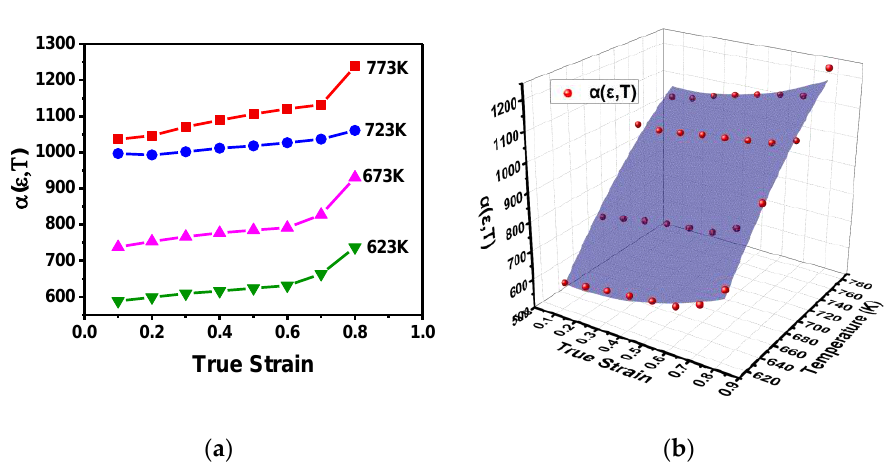
Figure 4. The variation of α : ( a ) at different strains and temperatures; ( b ) 3D illustration and its nonlinear surface fitting.